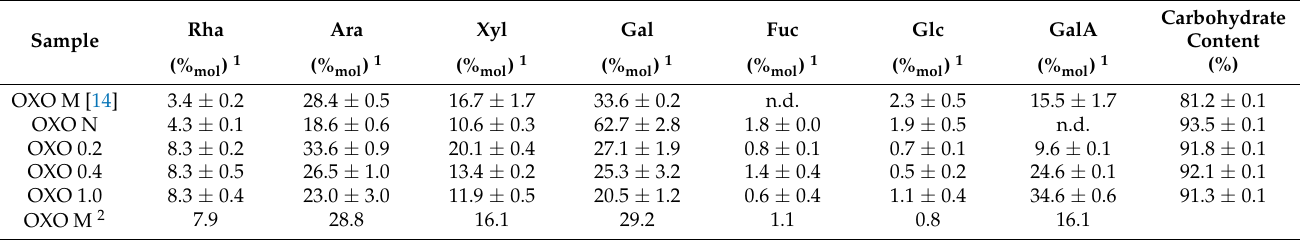
Table 2. Monosaccharide composition and total carbohydrate content of the heteropolysaccharides that compose the mucilage extracted from the cladodes of O. joconostle .